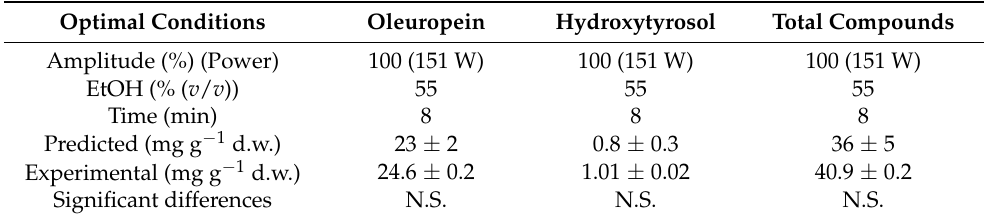
Table 3. Optimal conditions for oleuropein, hydroxytyrosol and total compounds for sonotrode UAE. N.S.: no significant